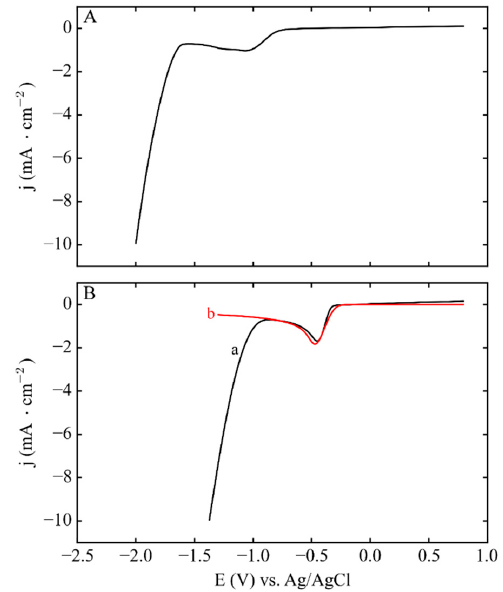
Figure 7. ( A ) Linear sweep voltammograms (LSV) of a bare HOPG electrode in 3 mM H 2 PtCl 6 , 0.5 M NaCl, pH 2.3, under N 2 and ( B ) For a Pt/HOPG electrode, same conditions as in ( A ). Line (a) shows the experimental data and line (b) the comparison to the digital simulations.